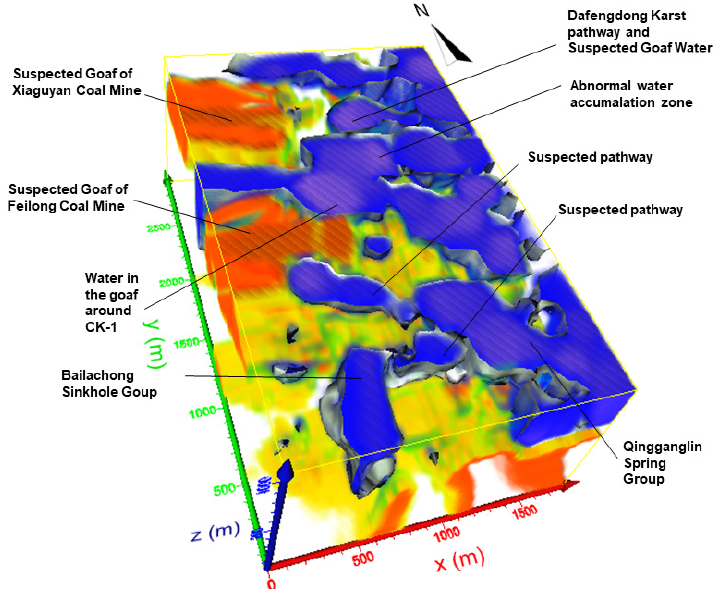
Figure 10. Results of transient electromagnetic survey.